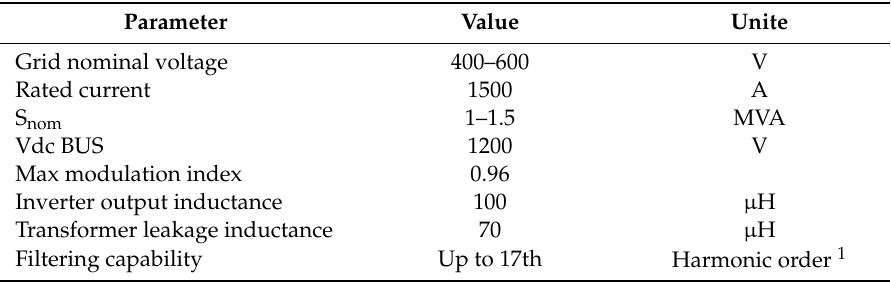
Table 1. Inverter